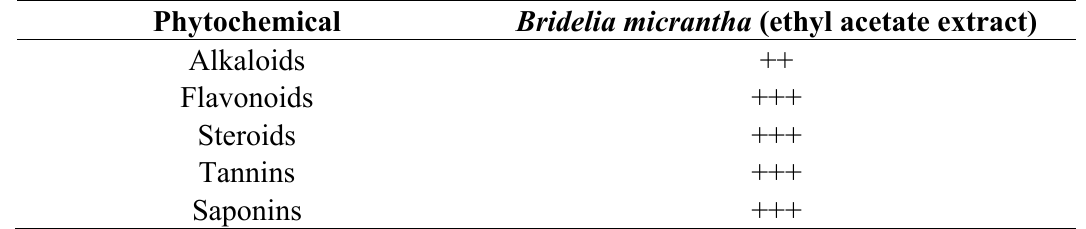
Table 4. Qualitative analysis of phytochemicals in the ethyl acetate extract of Bridelia micrantha